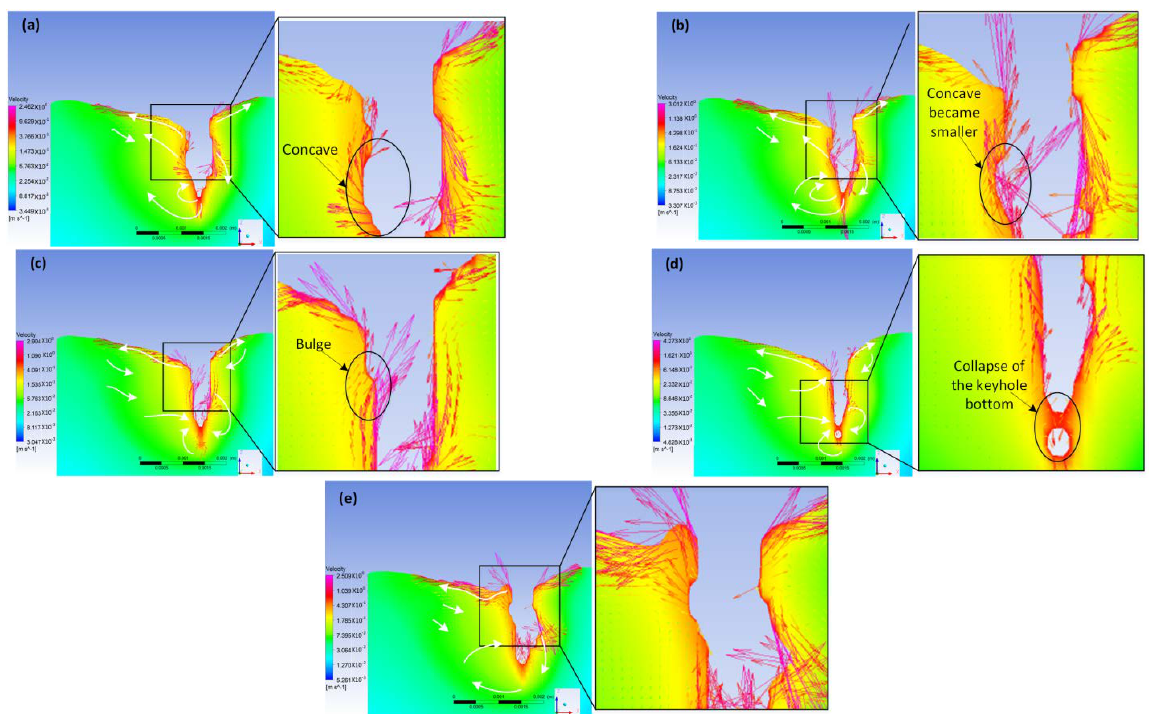
Figure 8. The melt flow behavior in the molten pool with preheating temperature of 400 K: ( a ) t = 26.4 ms, ( b ) t = 26.5 ms, ( c ) t = 26.7 ms, ( e ) t = 26.8 ms, ( e ) t = 29 ms.